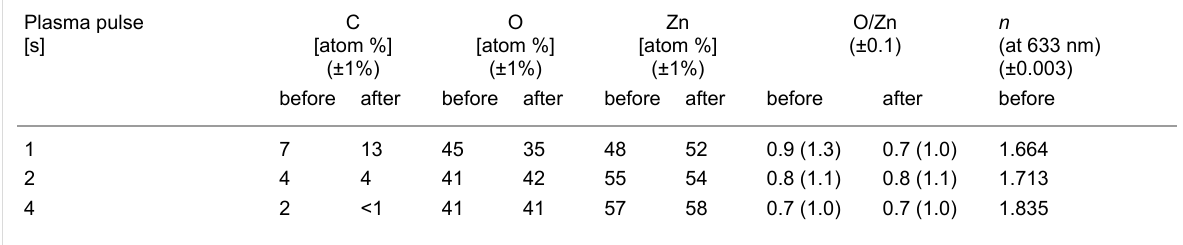
Table 1: Carbon, oxygen, and zinc atomic percentage (atom %) as measured by XPS for the zincone-like layers as a function of the plasma dose time. O/Zn ratios are also reported. Values before and after the annealing procedure are reported for all the elements. In brackets, the O/Zn calcu- lated from the value of pure bulk ZnO obtained from reference [58].